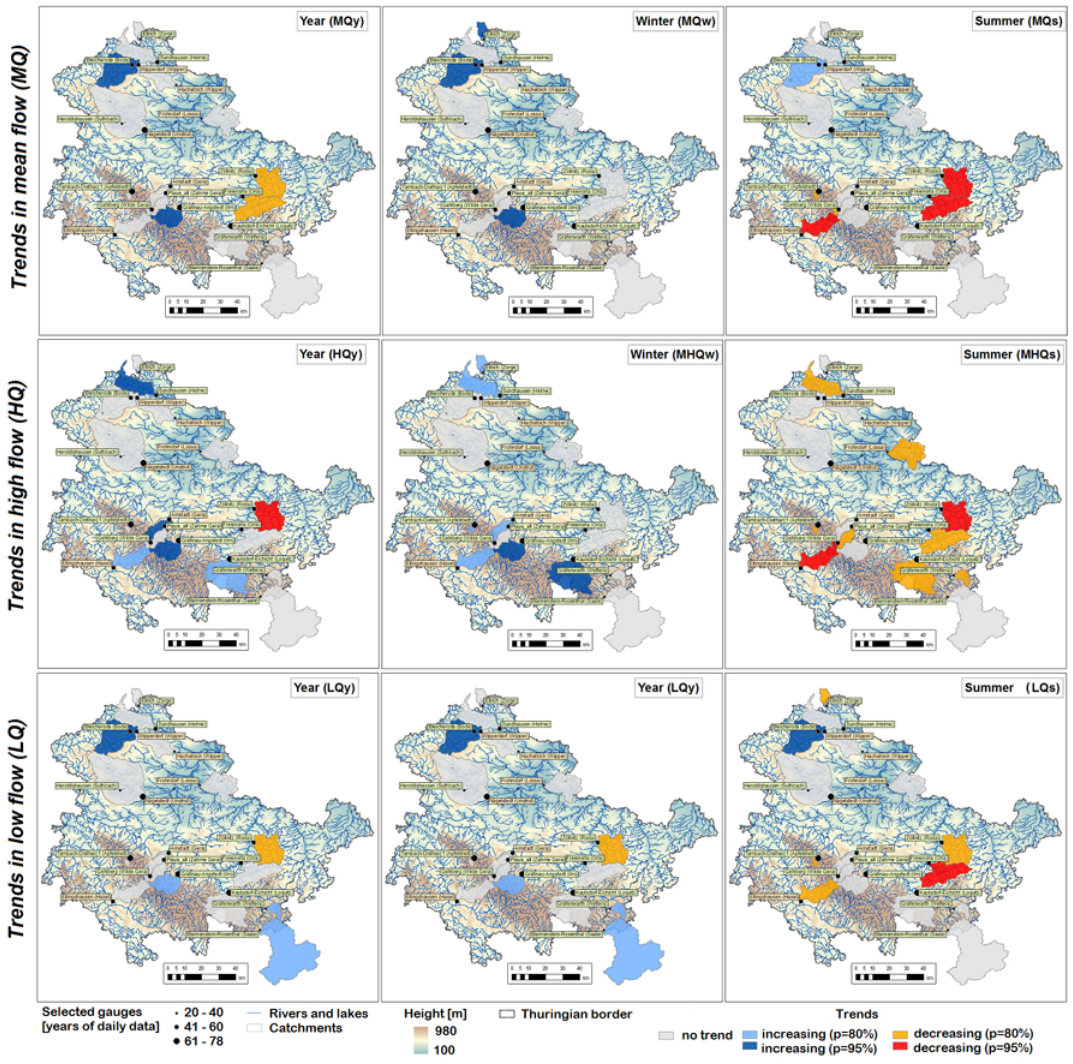
Fig. 3. Mann-Kendall trend results in mean flow, high flow and low flow time series in Thuringian catchments; increasing and decreasing trends are considered significant at a level of significance of 80% and highly significant at